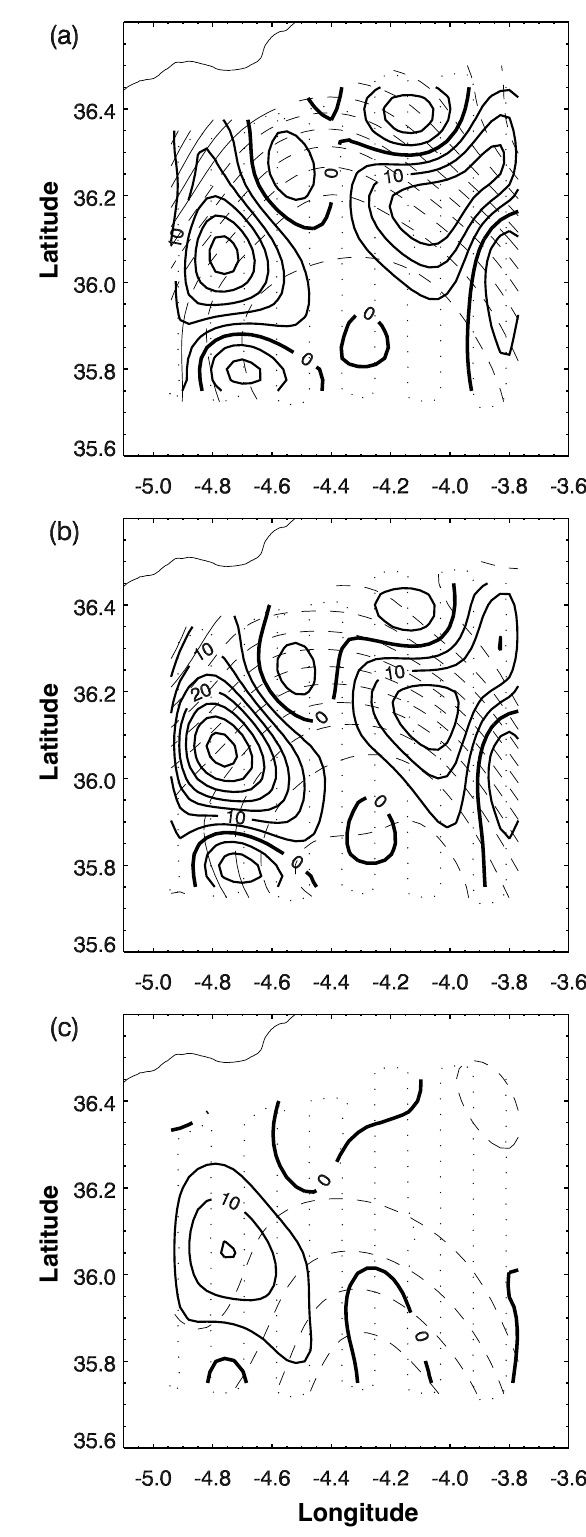
F IG . 5. – Maps of vertical velocity (m/day) calculated from the objectively analysed density data via the quasi-geostrophic omega equation at (a) 50 dbar, (b) 100 dbar and (c) 200 dbar. The 26, 27, 28 and 29 kg m -3 isopycnals are overlaid for reference as dashed